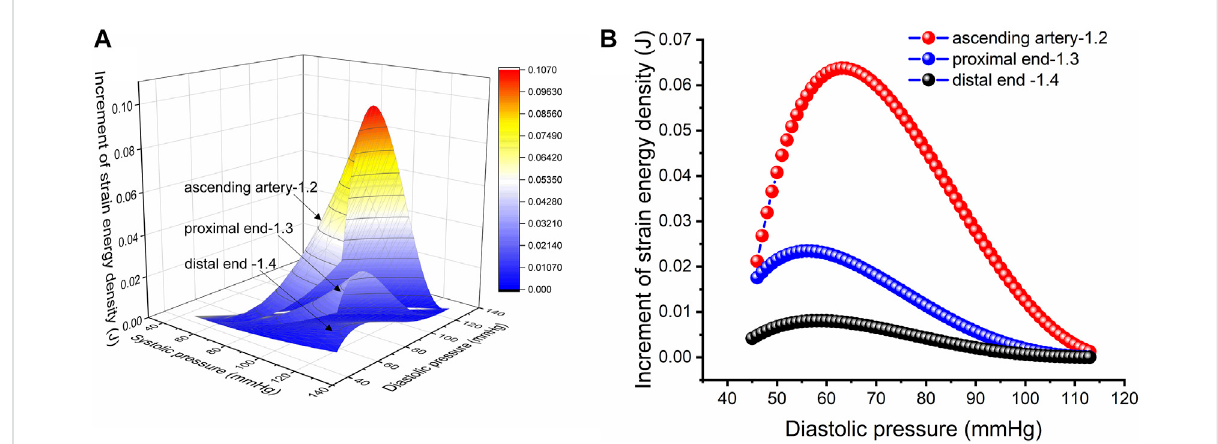
FIGURE 5 Strain energy density increment per unit length. (A) Increment in strain energy density per unit length of the aorta with an in vivo axial stretch ratio of 1.2, 1.3 and 1.4 for the ascending, proximal descending and distal descending arteries, respectively. (B) Increment in strain energy density per unit length upon in vivo axial stretch for the ascending, proximal descending and distal descending arteries, respectively, with an SBP of 113